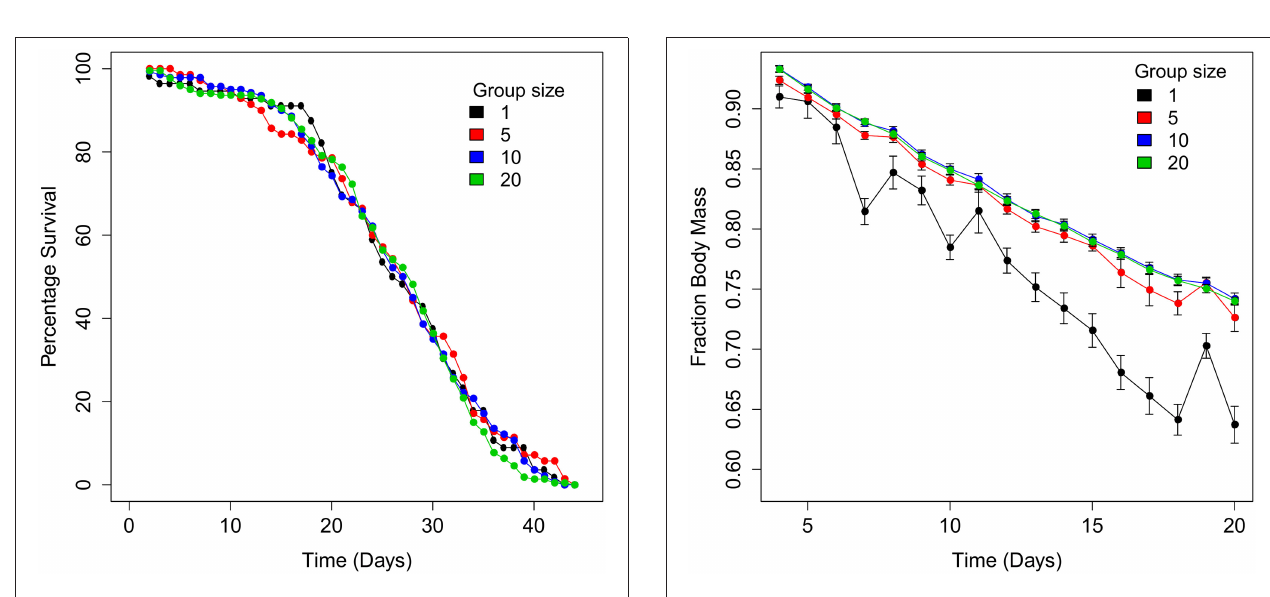
FIGURE 6 | The mean ( ± SE) mass loss rate between day 4 and 20 of Stegodyphus dumicola spiders subjected to desiccation at four different group sizes. Spiders kept individually had a significantly higher mass loss rate than spiders kept in larger